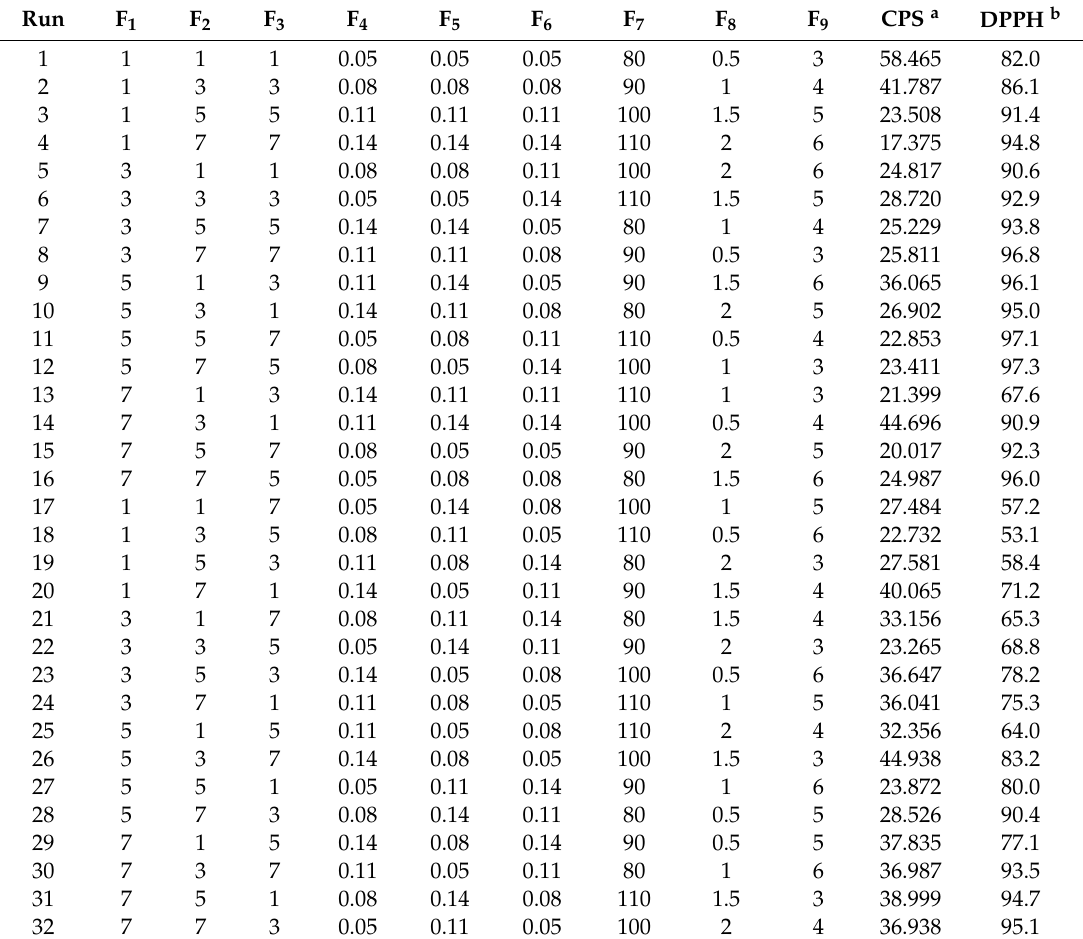
Table 2. Result of orthogonal